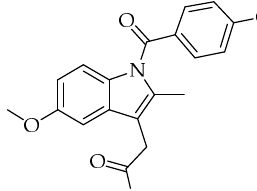
Figure 1. Indole-based anti-NSCLC agents.